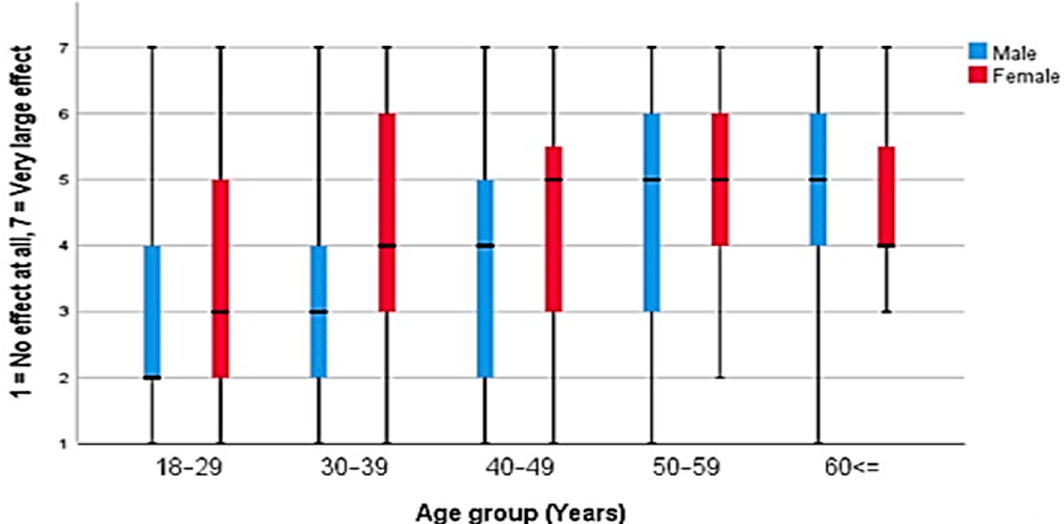
Figure 2. The effect of language barriers among adult participants according to sex and age.